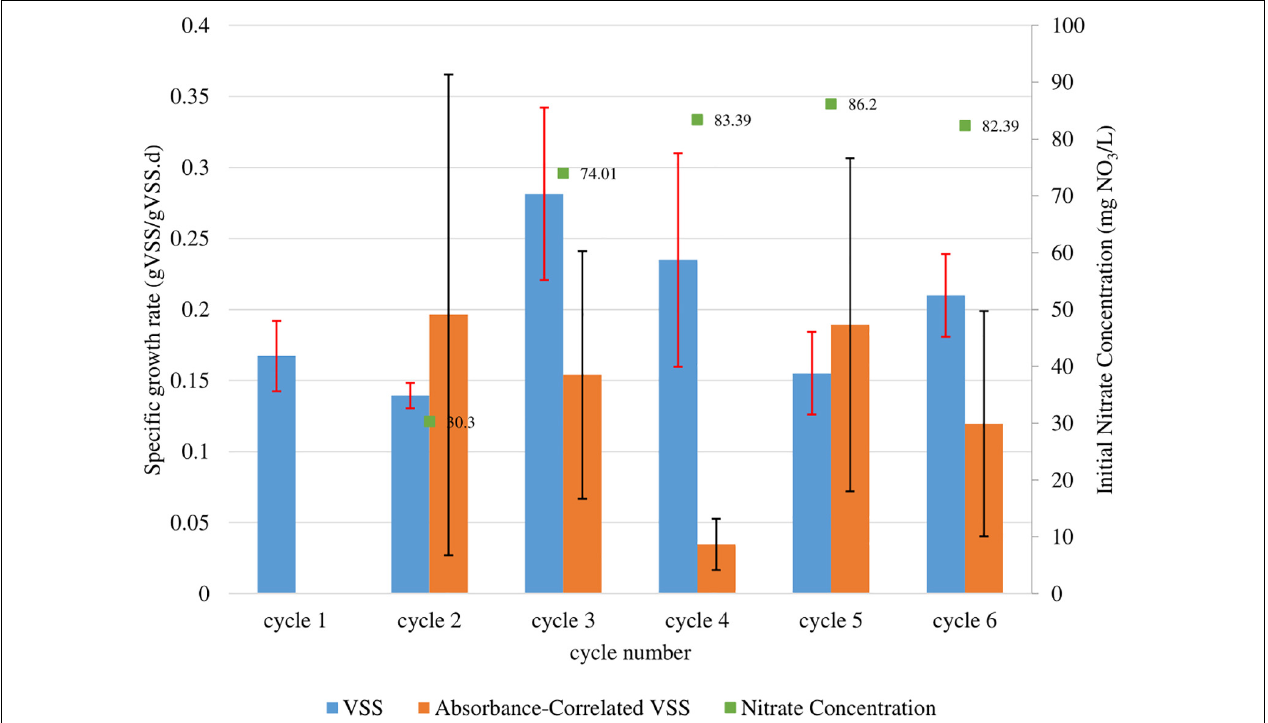
FIGURE 4 | Observed maximum growth rates of T. chuii calculated from fitted growth curves for each batch cycle run. These growth rates were calculated from the change of mass (gVSS/L) (blue) , as well as by absorbance using the correlations obtained for OD550 (orange) . Red and black error bars correspond to the 95% confidence interval of the calculation for the VSS and absorbance correlated VSS biomass quantification methods respectively. The starting NO 3 concentrations for each batch are also shown above each bar (green) .